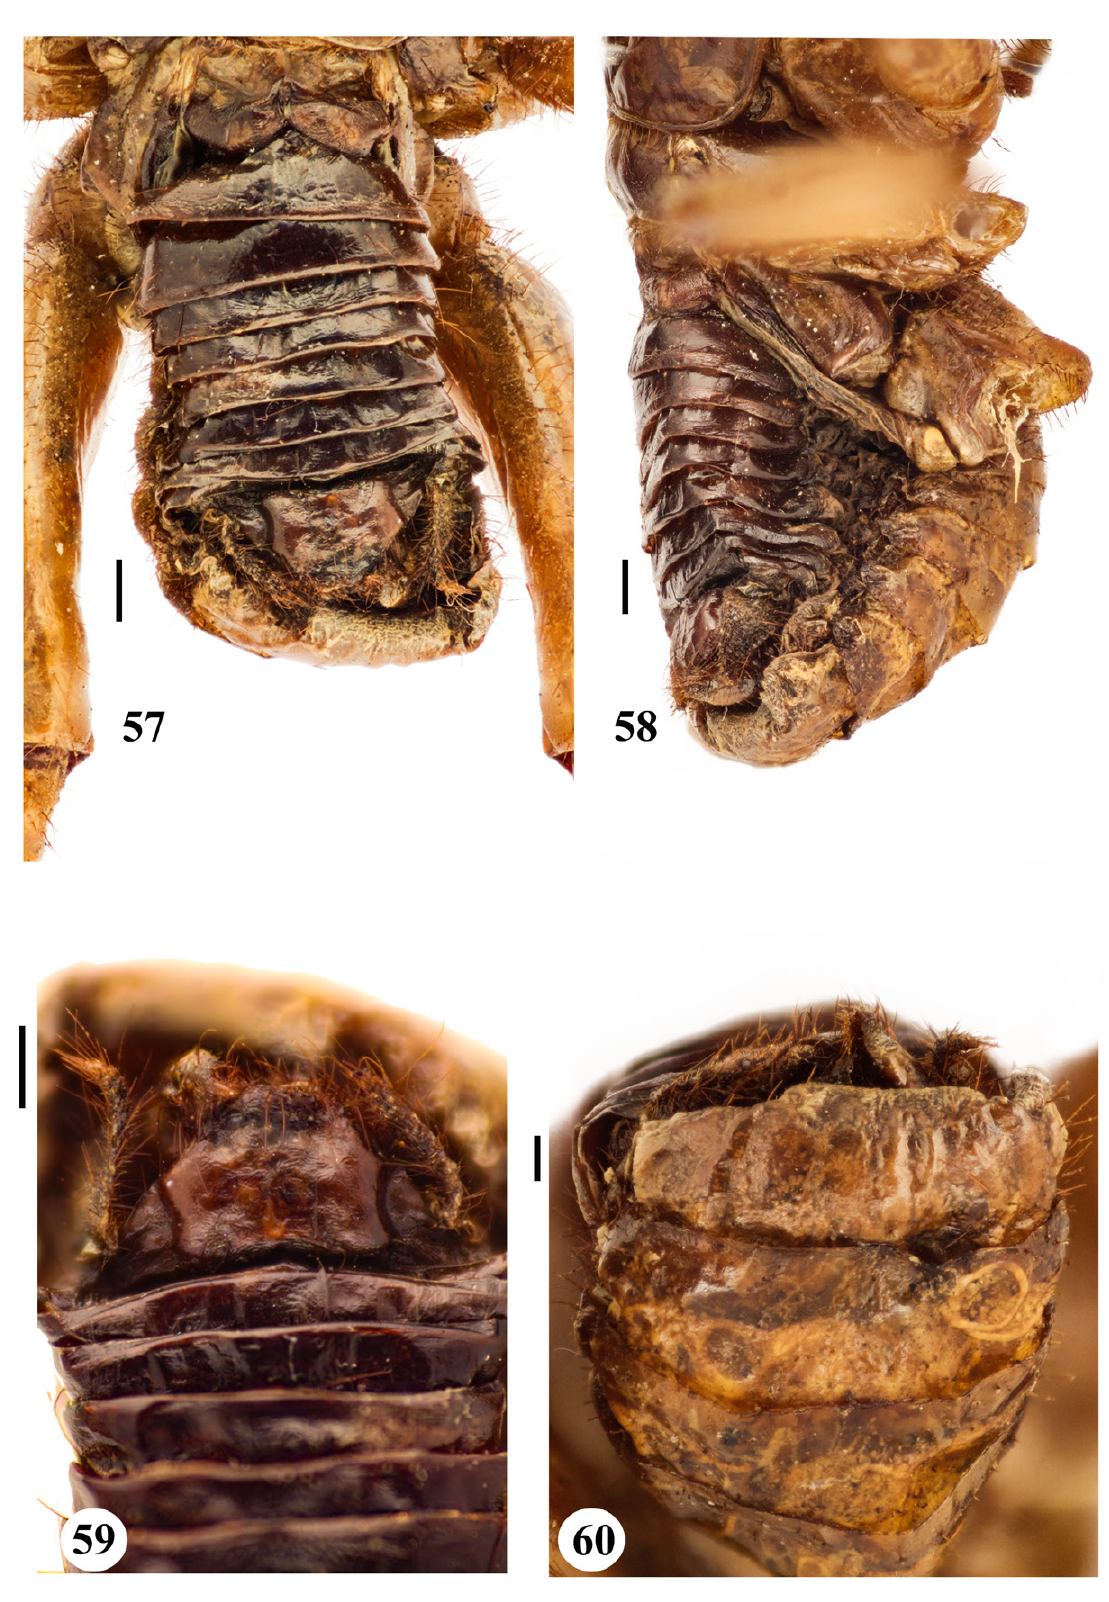
Figs 57–60. Oryctopterus yeshwanthi sp. nov. Holotype, ♀ (UASB). 57 . Abdomen, dorsal